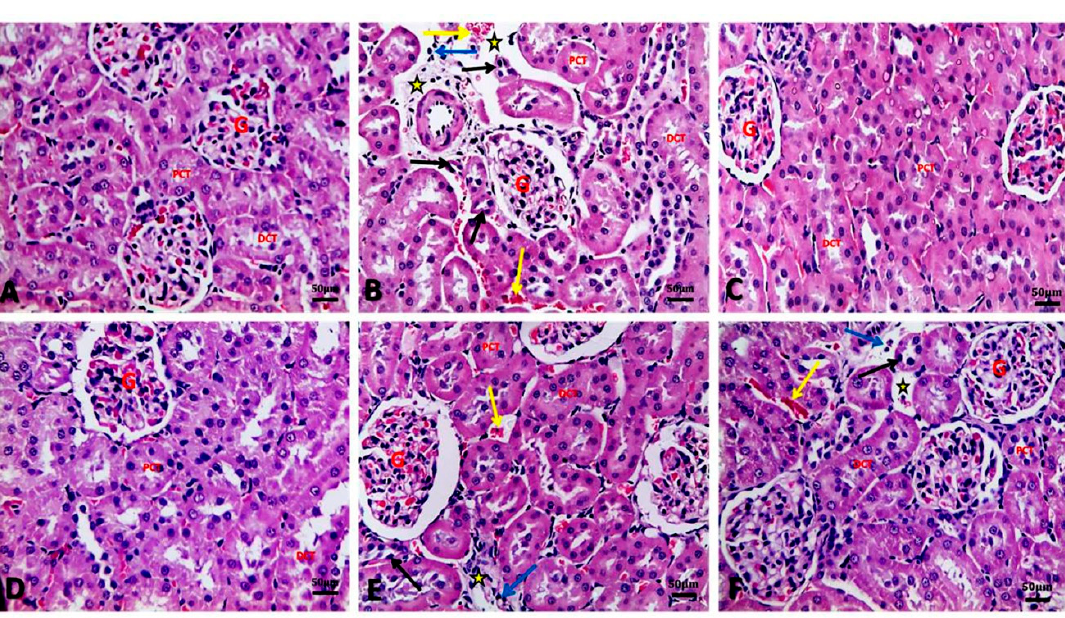
Table 4. The main histopathological changes recorded in kidneys of the different treated groups. Experimental Groups Lesions Control BM AO/0.5 AO/1 BM+AO/0.5 BM+AO/1 Vascular Changes − ++++ − − + + Degenerative Changes − +++ − − + + Inflammatory Changes − ++ − − + + The histopathological changes are graded as follows: ( − ) indicates normal appearance, (+) indicates mild changes, (++) indicates moderate changes, (+++) indicates severe changes, and (++++) indicates very severe changes. BM: betamethasone and AO: argan oil.